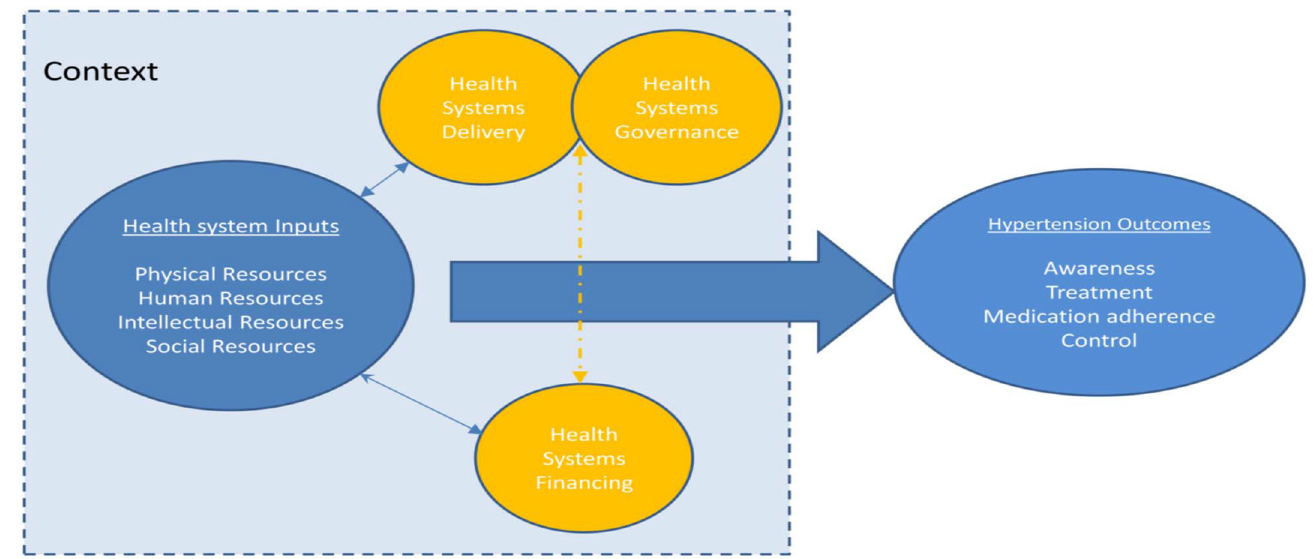
Fig 1. Health Systems Schematic Diagram. Adapted from